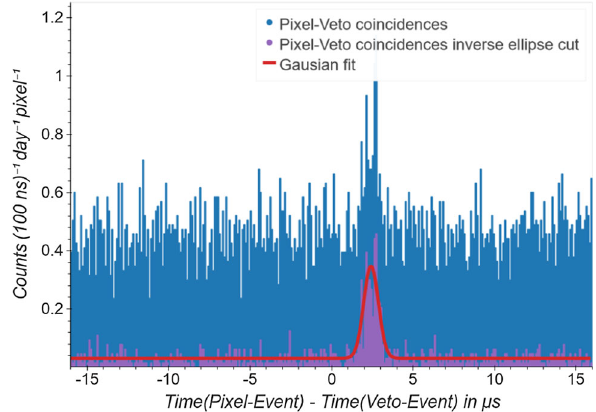
Fig. 15 Thetimedifference δ t betweenthepixeleventsandmuonveto events δ t = t (pixel event) − t (veto event). The events showed in blue are all pixel events. The fraction, which are located outside of at least one of the three ellipses is shown in purple. The amount of random coincidences is clearly reduced. And (muon induced) substrate events are located outside of the ellipses